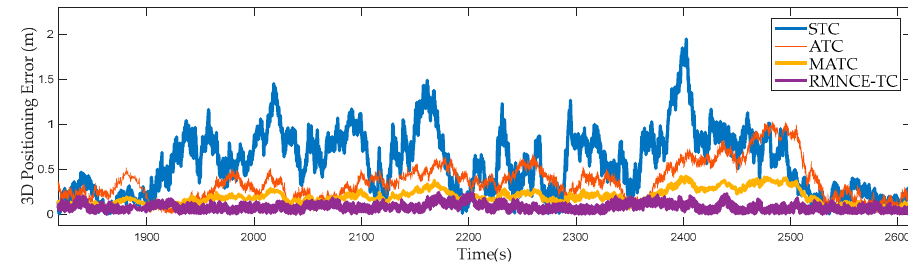
Figure 7. 3D positioning errors of the selected schemes during [1900 s, 2500 s]. Table 5. Satellite selection results of the different schemes at the 2050-th second. Selected Satellites ID GDOP